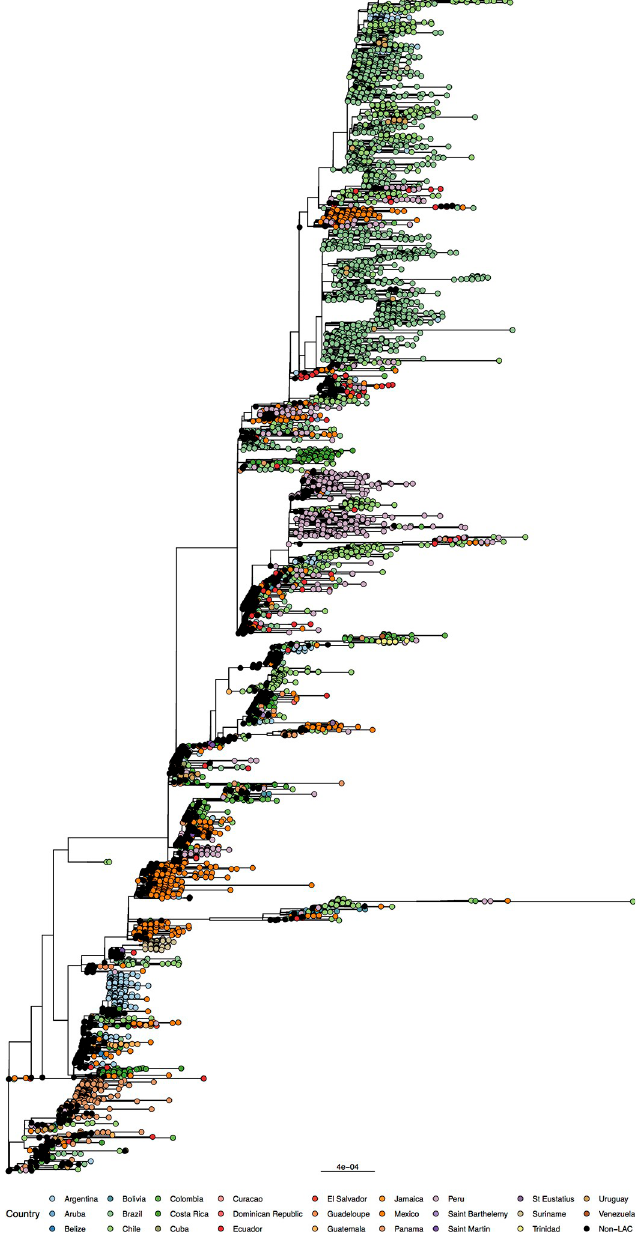
Fig 3. Maximum-likelihood phylogeny of the SARS-COV-2 circulating in Latin America and the Caribbean regions. Countries sequences marked by colored circles.